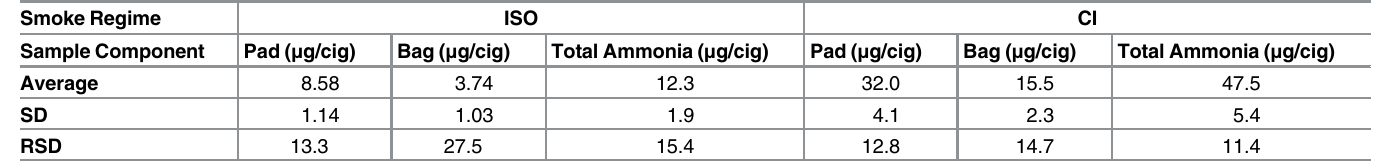
Table 2. Precision data for the ammonia in mainstream cigarette smoke method using the 3R4F reference cigarette.